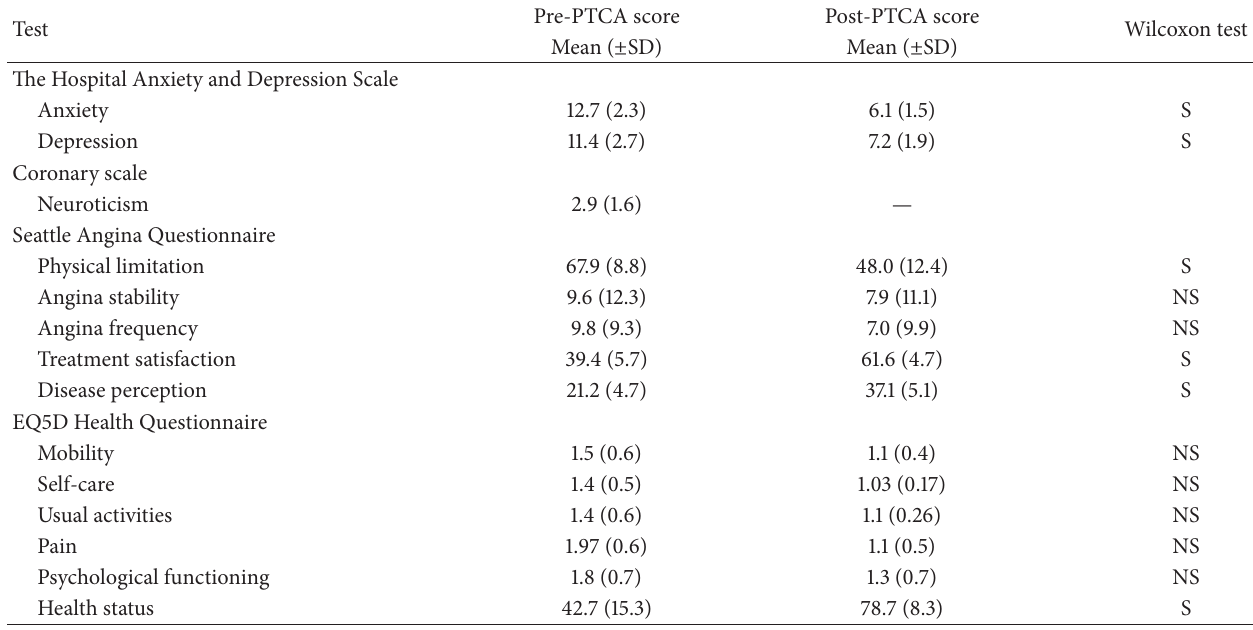
Table 2: Psychological test results of the patients undergoing